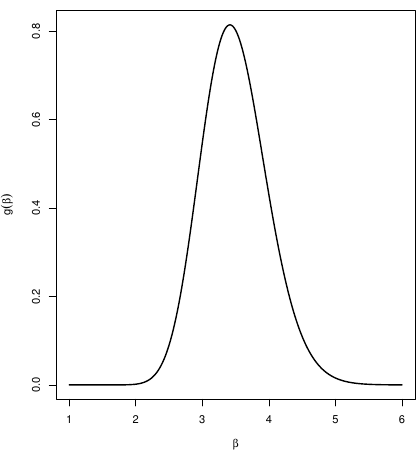
Figure 2. The full conditional distribution of β